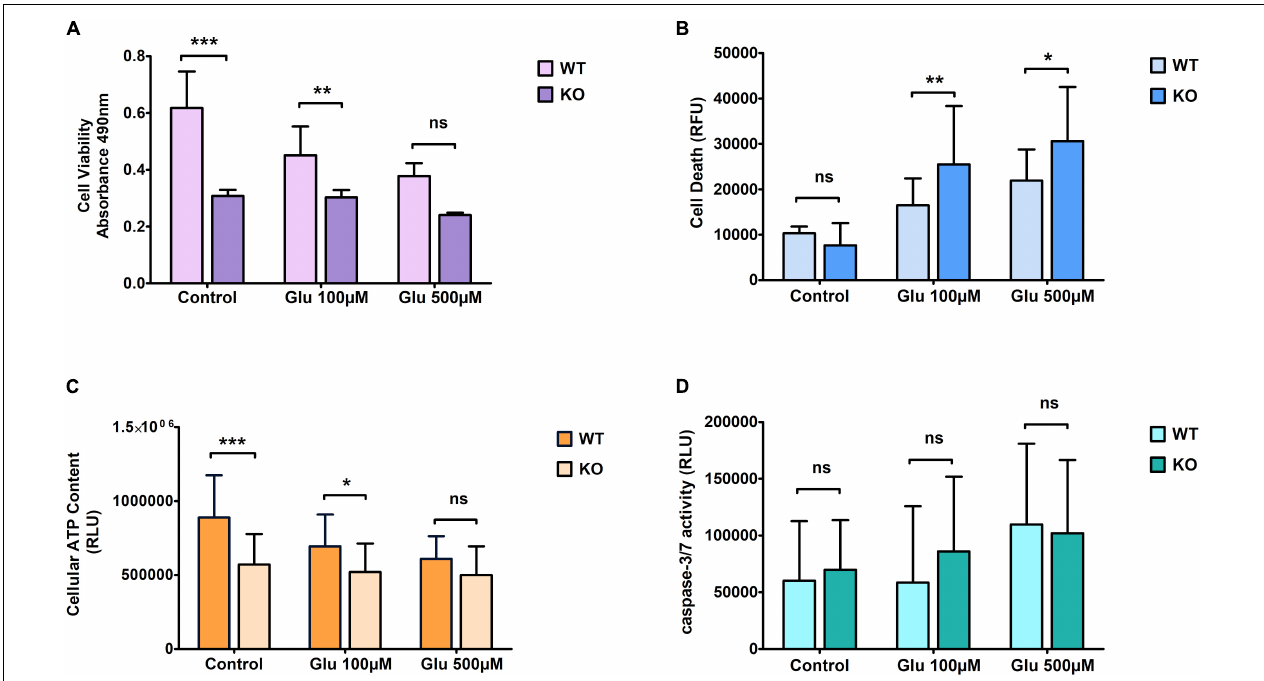
FIGURE 2 | Effect of glutamate excitotoxicity at different concentrations on primary cortical cells of WT and KO. Cell viability (A) , Cell death (B) , ATP levels (C) , and Caspase 3/7 activity (D) was measured using various cell plate-based assays. Graphs represent mean with SD of 18–25 data points from independent cell culture wells. Two-way ANOVA was performed with Bonferroni post-hoc test to compare KO and WT for cells exposed to glutamate toxicity with significance levels (* ≤ 0.05, ** ≤ 0.01, and *** ≤ 0.001).